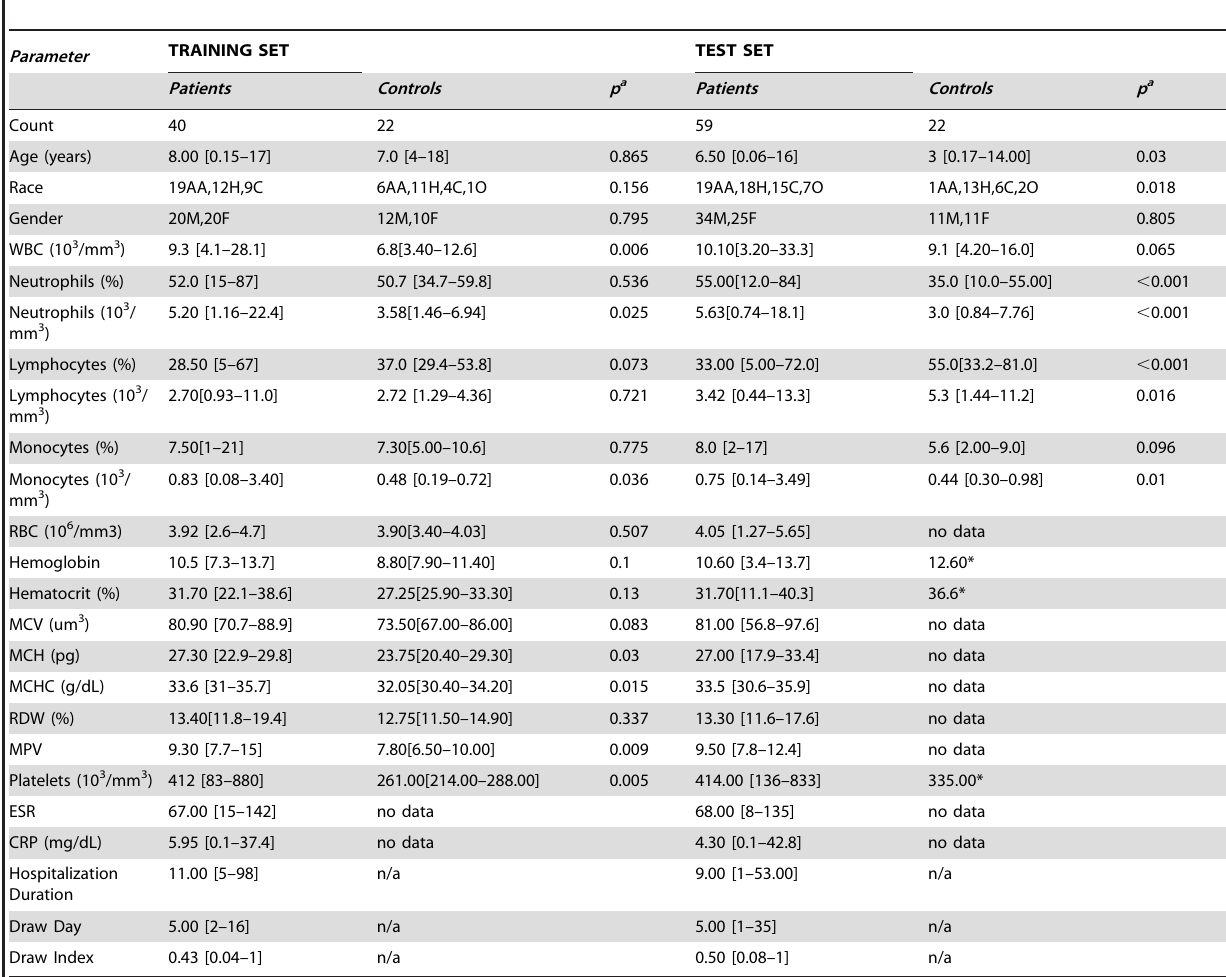
Table 1. Demographic and laboratory characteristics of patients and healthy controls in training and test